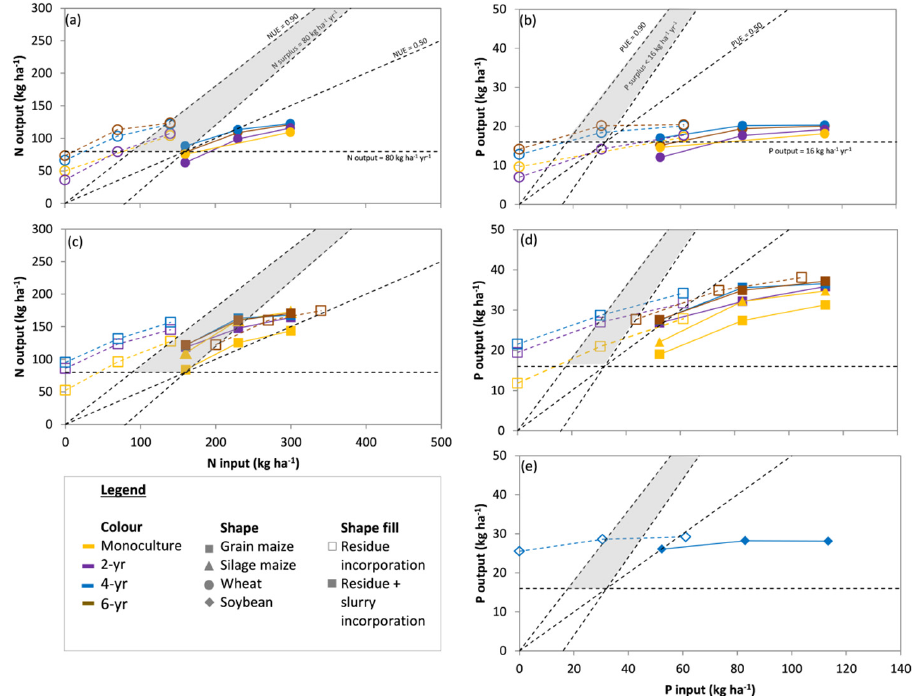
Figure 6. Graphical presentation of the nitrogen ( a , c ) and phosphorus ( b , d , e ) use efficiency (UE) in to crop rotations using colour (monoculture, 2, 4, and 6 yr) and characterised by different